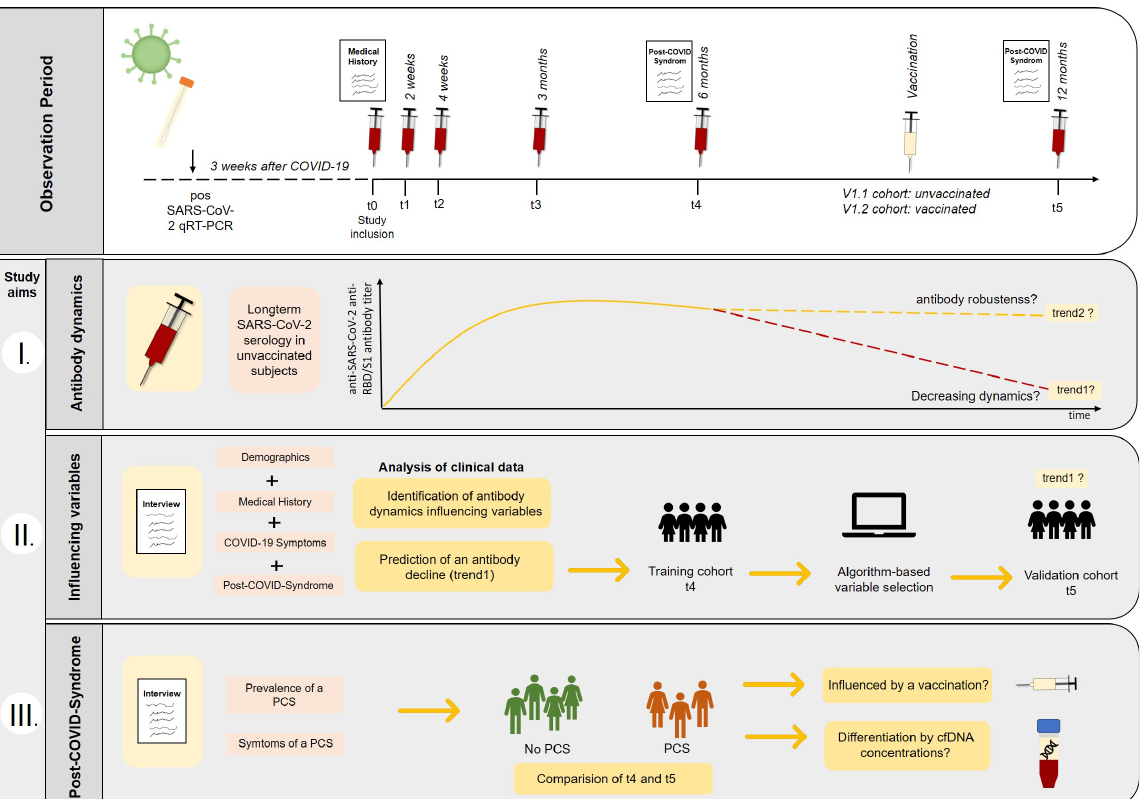
Figure 1. Observation period and study aims. Recovered COVID-19 subjects were enrolled into the study and longitudinal follow-up was performed, including blood sampling and structured inter- views. I. Long-term SARS-CoV-2 serology was monitored in unvaccinated subjects to assess declin- ing (trend1) and stable antibody dynamics (trend2). Moreover, the booster effect of vaccination was investigated. II. Clinical data were examined to find variables that could help to identify subjects having a higher risk for declining anti-SARS-CoV-2-antibody titers (trend1). A random forest algo- rithm was used to identify potential dynamics predicting variables based on the t4-training (6 months) cohort, and potential models were validated using unvaccinated t5 subjects (12 months). III. The prevalence and the symptoms of a post-COVID-syndrome (PCS) were compared between t4 (6 months) and t5 (12 months) appointments. Furthermore, the discriminatory potential of cfDNA concentrations collected in the early post-disease phase (t0) was evaluated, and the impact of vac- cination on a preexisting PCS was considered. 2.2. Long-Term Appointments and Definition of Cohorts SARS-CoV-2 infected subjects confirmed by qRT-PCR were included in the study at least 3 weeks after recovery from COVID-19 disease (t0). These subjects were monitored longitudinally for the development of anti-SARS-CoV-2-anti-N- and anti-RBD/S1-anti- bodies at defined time intervals after study inclusion: t1: 2 weeks; t2: 4 weeks; t3: 3 months; t4: 6 months; t5: 12 months (see Figure 2 and Table 1). The results up to t4 have been published previously. Therefore, the results from t5 (12-month appointment) are pre- sented in this work.